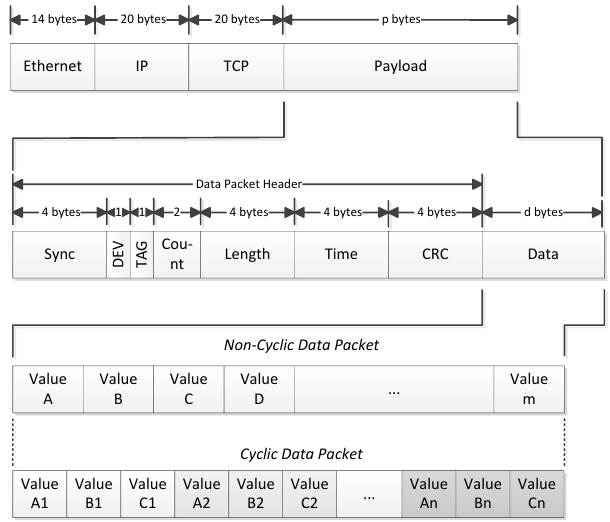
Figure 3. Structure of a GLORIA housekeeping data packet, with its header, encapsulated in a TCP/IP frame. The data block of the data packet can be either noncyclic, where every defined data value is only included once, or cyclic, where each defined value is re- peated n times. A mixed mode where the first values are present only once and the last ones are repeated as with the cyclic mode is also possible (not illustrated). The length of the data packet includes the header as well as the n repetitions of a cyclic data